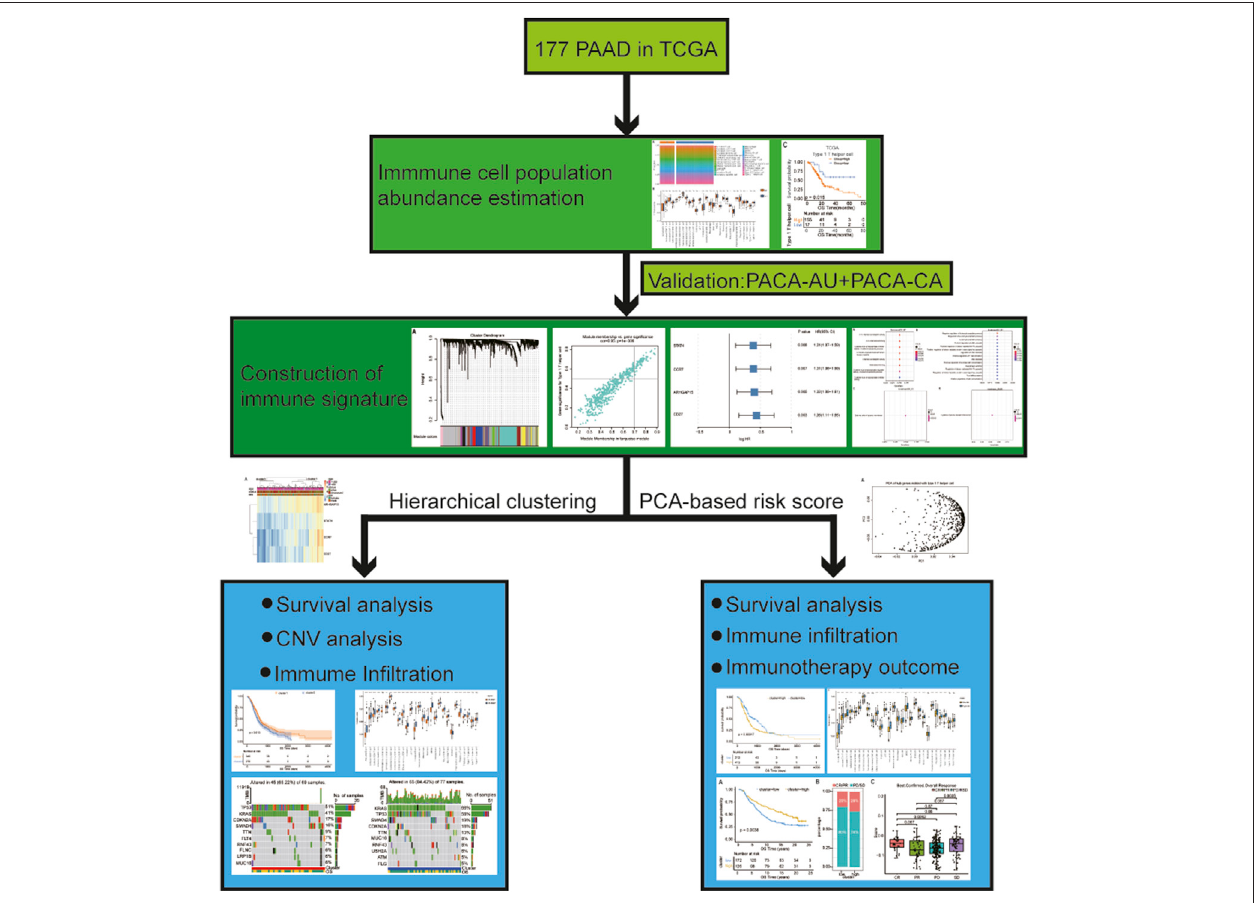
FIGURE1| Thework fl owofthisanalysis.Inbrief,wecomparedtheabundanceofimmunecellpopulationsbetweenPDACpatientswithlymphnodemetastasisandwithout usingssGSEA.Then,survivalanalysisofthesedifferentialin fi ltratedimmunecellswasperformed,andweselectedthecell(Xcell)withthemostsigni fi cantdifferenceforsubsequent analysis. After that, we screened the coexpression module depicting the highest correlation with the X cell in fi ltration ratio using WGCNA and further found out the hub genes associatedwithXcelldensitythroughunivariateCoxregressionanalysis.Wecontinuetoanalyzedthesubtypesbasedongenesignatureintwoways:1)Subtypesobtained byhierarchicalclusteringanalysis:analyzingtheassociationofdifferentsubtypeswithsurvivaloutcome,CNV,andproportion ofimmunecellsin fi ltration;2)Subtypesobtained by PCA-basedriskscore:constructingariskmodelbasedongenesignatureandthenanalyzingtheassociationbetweendifferentsubtypeswithsurvivaloutcome,CNV,proportionof immunecellin fi ltrationandimmunotherapyoutcome, etc .Abbreviations:PAAD,pancreaticadenocarcinoma;PDAC,pancreaticductaladenocarcinoma;ssGSEA,single-sample Gene Set Enrichment Analysis; WGCNA, weighted gene co-expression network analysis; CNV, copy number variation; PCA, principal component analysis.